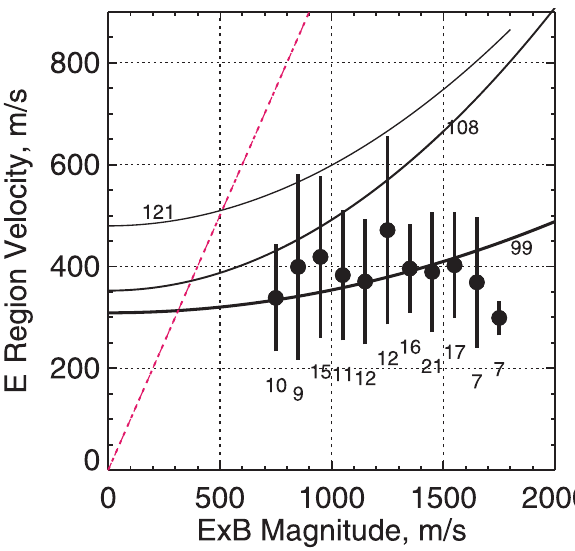
Fig. 9. Maximum E-region velocity (derived from the Stokkseyri scan data and fitting procedure) for various E × B drift magnitudes. Successful fittings for four events were considered: 1 Novem- ber 2001, 17 November 2001, 15 January 2002 and 3 March 2002. Solid lines are the dependence C S ( E × B ) at the heights of 99, 108 and 121km, reported in Fig. 1.